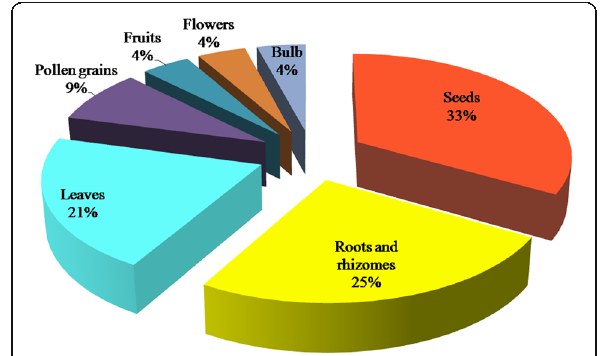
Fig. 5 Frequency of parts used from the utilized plants in the treatments of infertility in males in the West Bank